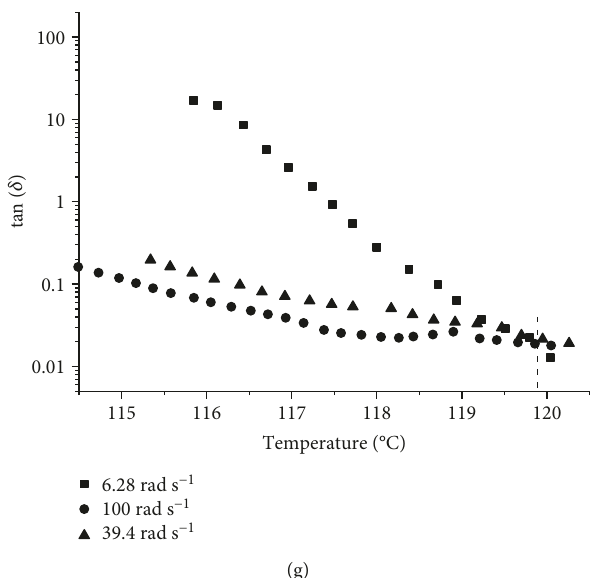
Figure 2: Temperature sweep for the polythiourethane system at di ff erent frequencies. Changes of G ′ , G ″ , and η ∗ with temperature at (a) 6.28rad s -1 , (b) 39.4rads -1 , and (c) 100rad s -1 . Changes of tan δ with temperature at (d) 6.28rads -1 , (e) 39.4rad s -1 , and (f) 100rad s -1 . (g) Local region of the temperature sweep data showing the crossover of the tan δ curves at three